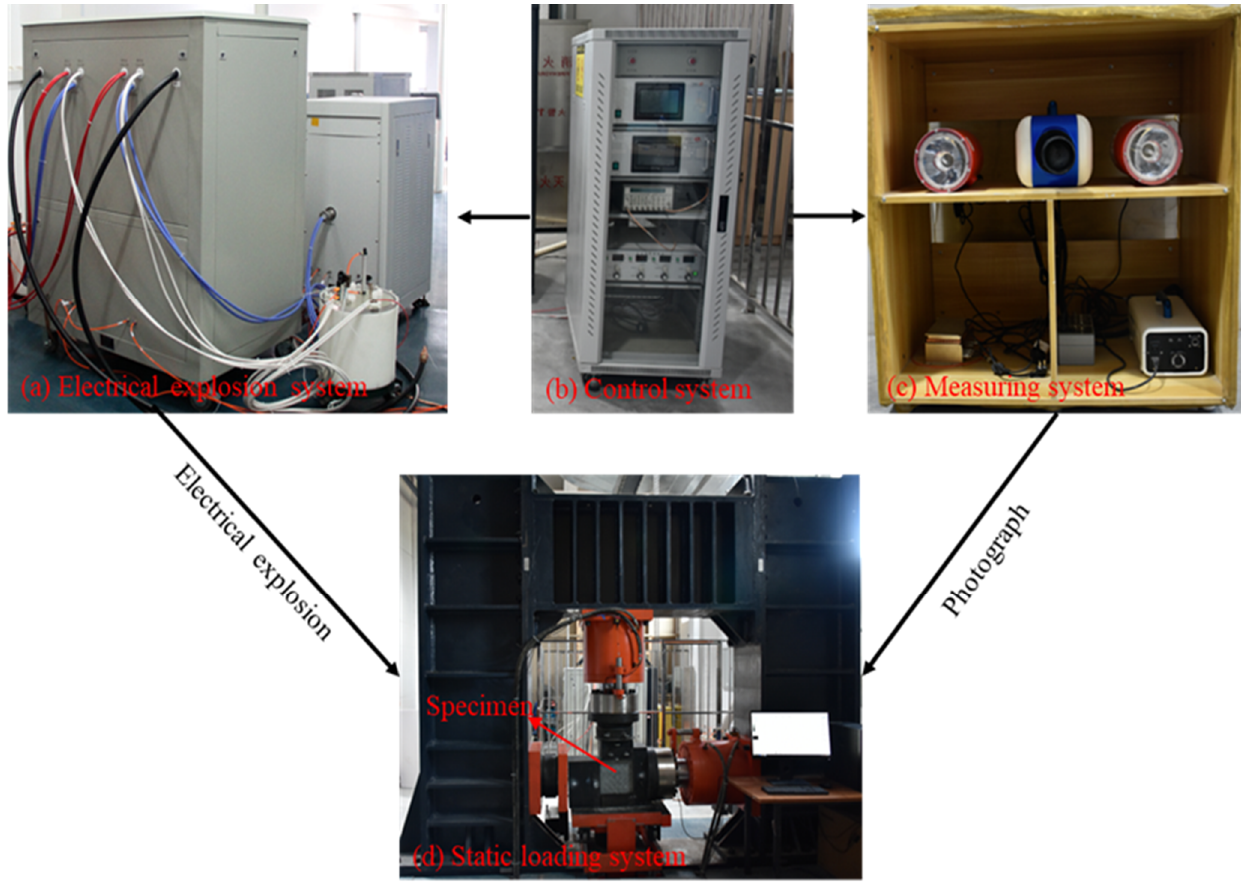
Figure 1. Experimental apparatus. ( a ) Electrical explosion experimental system; ( b ) control system; ( c ) measuring system; ( d ) static loading system.